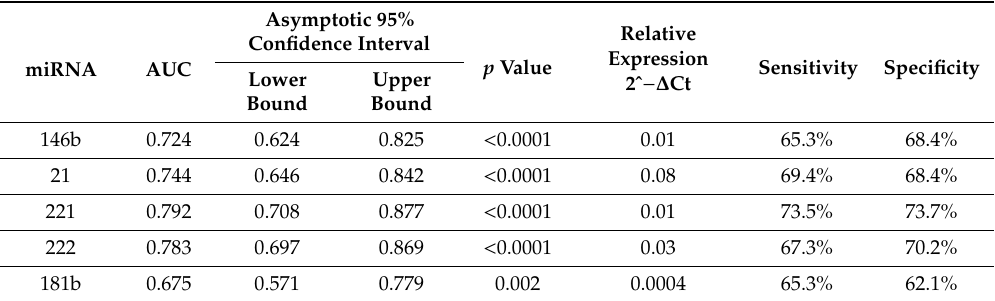
Table A4. ROC curves analysis for plasma miR-146b, miR-21, miR-221, miR-222 and miR-181b to discriminate papillary thyroid cancer patients from healthy control.